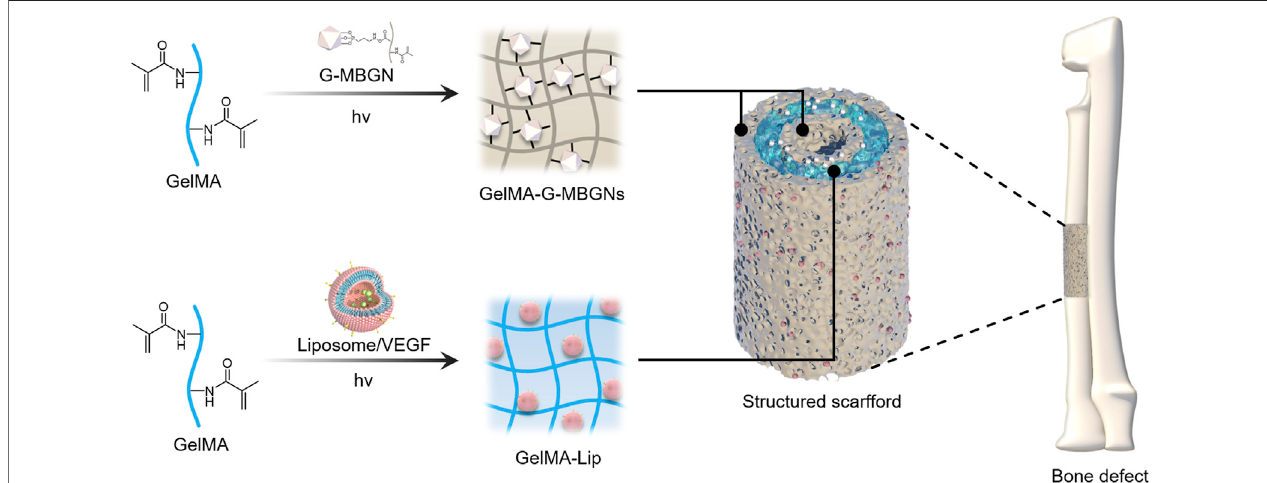
FIGURE 1 | Schematic illustration.